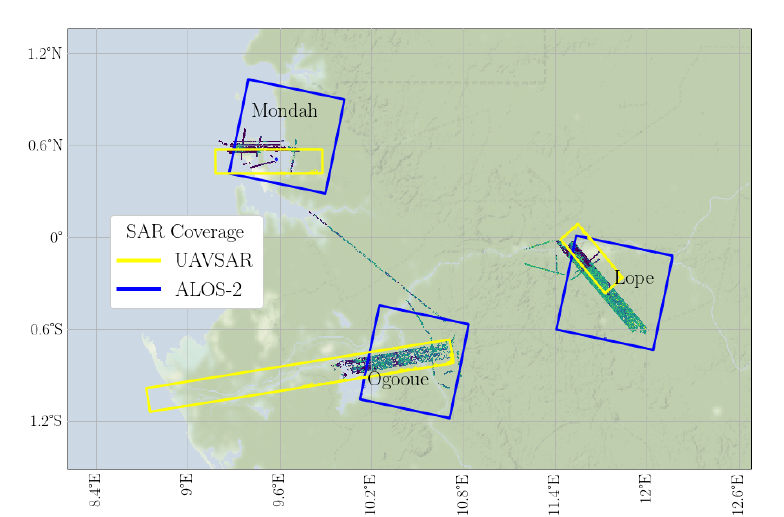
Figure 1. The AfriSAR above ground biomass (AGB) raster data and related SAR coverage at three sites in Gabon. Blue outlines the ALOS-2/PALSAR-2 stripmap tile extents and yellow outlines the UAVSAR backscatter flight lines.